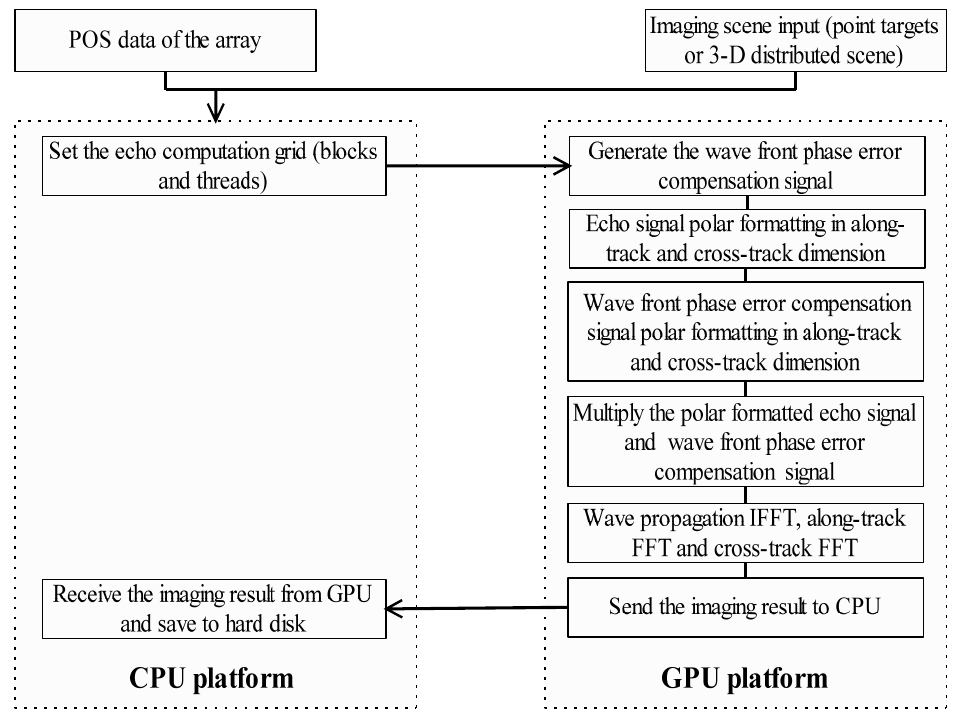
Figure 6. Heterogeneous parallel image reconstruction simulation with 3-D polar format